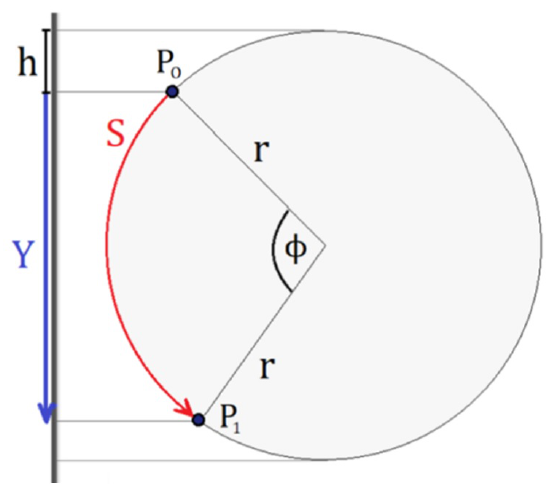
Figure 5. kinematics of the torsion test for 2D Digital Image Correlation (DIC)